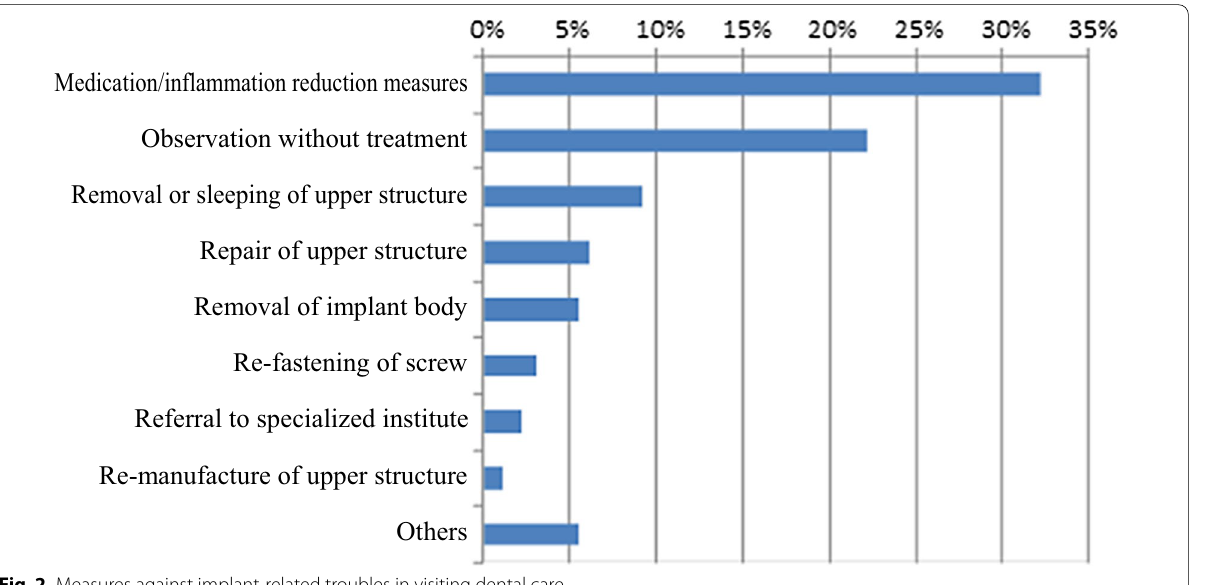
Fig. 2 Measures against implant-related troubles in visiting dental